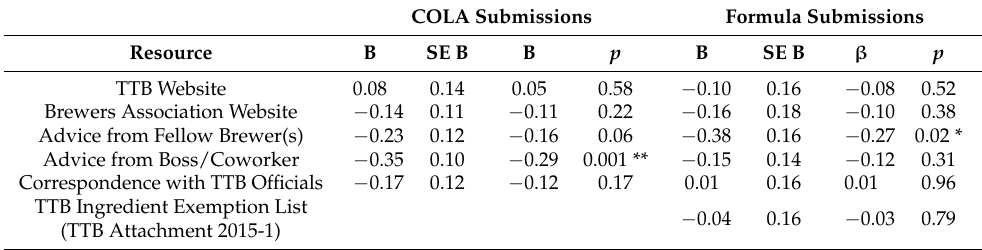
Table 11. Prediction of Expense Burden Using Resource